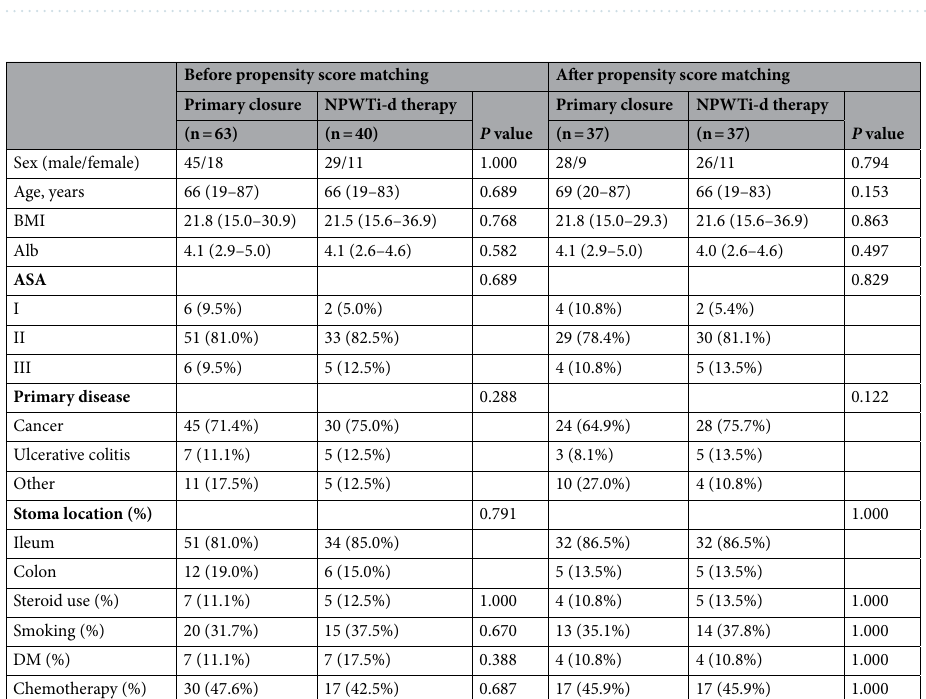
Figure 4. Flowchart of the patients selection.